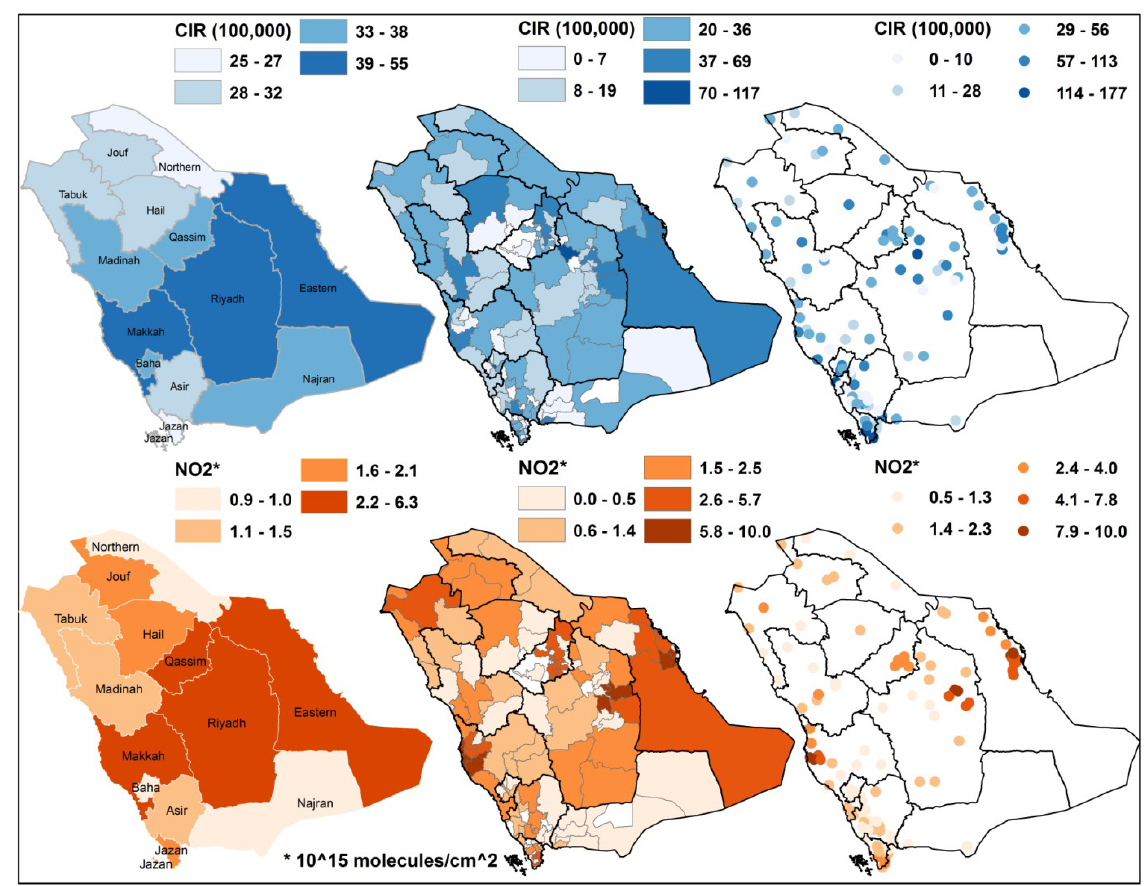
Figure 3. Crude incidence rates of all cancers for the regions, governorates and cities